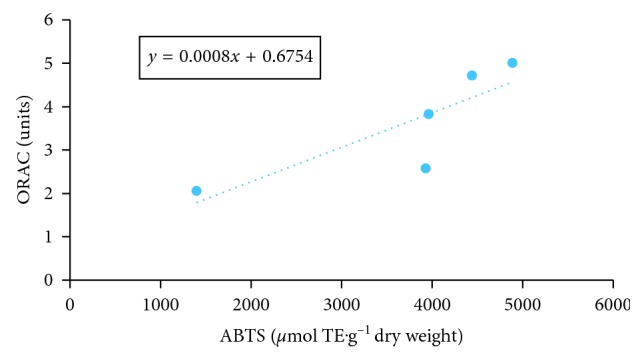
Correlation between ABTS and ORAC assays.